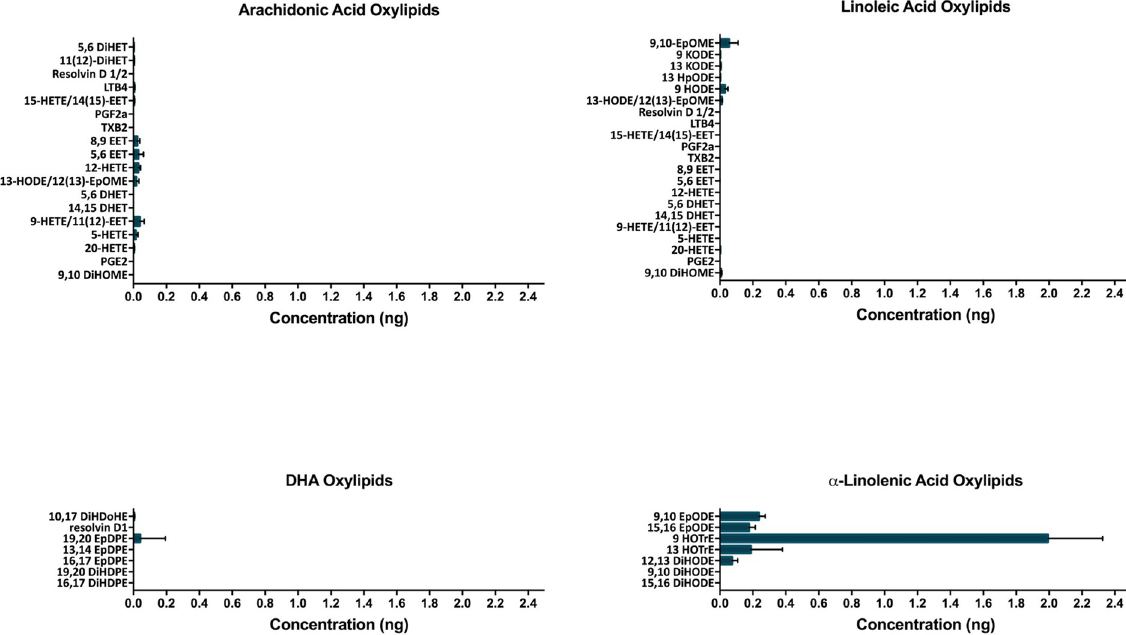
Fig 2. PUFA metabolites of CYP2B6. LC-MS/MS was used to measure production of oxylipid metabolites formed by CYP2B6 containing baculosomes compared to control baculosomes incubated with 25 μ M arachidonic acid, linoleic acid, docosahexaenoic acid, and α -linolenic acid (n =